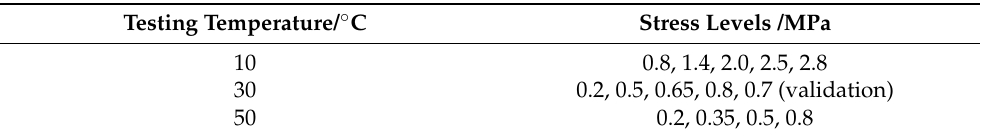
Table 3. Creep experiment conditions of asphalt